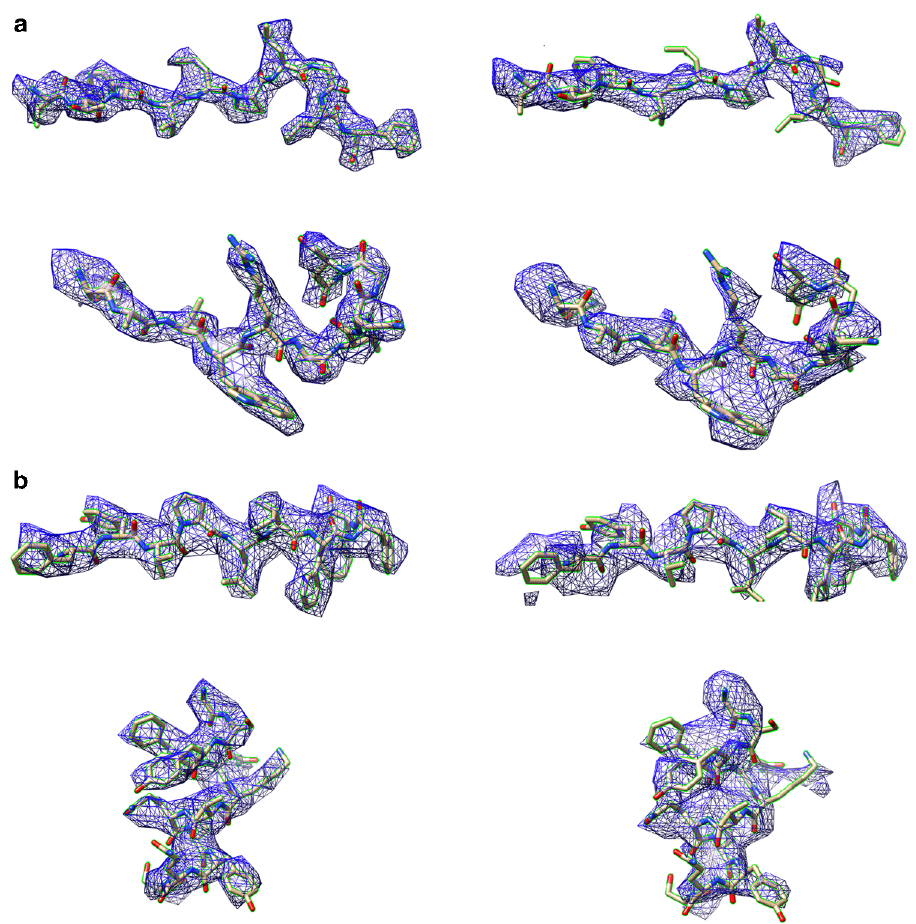
Fig. 3 Comparison of cryo-EM densities from block-based and conventional reconstruction methods. a The densities belong to the major capsid protein in the 3.1 Å resolution HSV-2 reconstruction by block-based reconstruction method (left) and the densities that were from the same areas in the 4.0 Å resolution reconstruction by conventional method (right). The HSV-2 virus structure data are deposited in the Protein Databank with accession code 5ZAP (HSV-2 icosahedral reconstruction after block-based re fi nement) and in the Electron Microscopy Database with accession code EMD-6907 43 . b The densities belong to the major capsid protein Vp54 in the 3.5 Å resolution PBCV-1 reconstruction by the block-based reconstruction method (left) and the densities that were from the same areas in the 4.2 Å resolution reconstruction by the conventional method